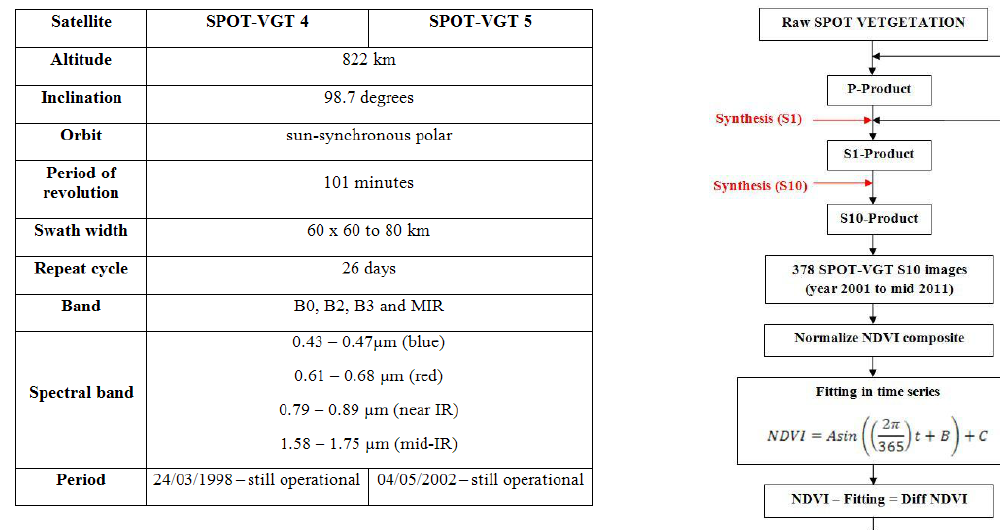
Table1. Characteristics of SPOT-VGT 4, 5